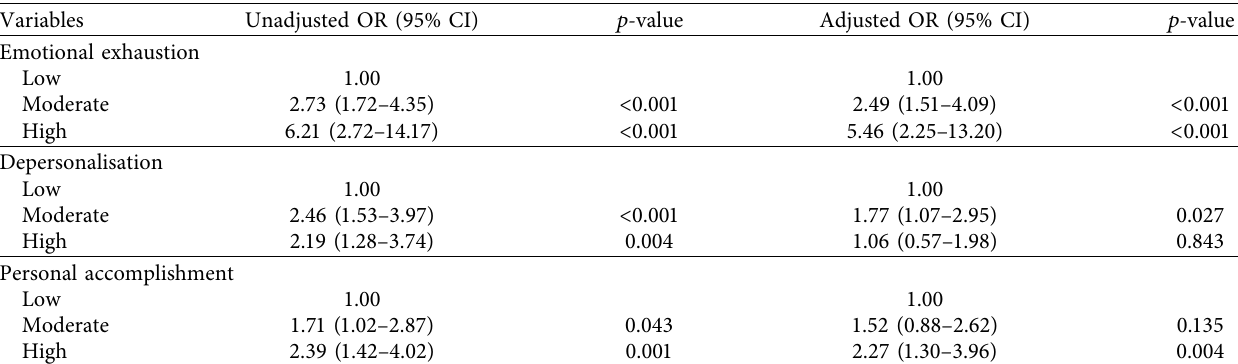
Table 4: Multiple logistic regression analysis of the relationship between burnout and intention to quit among study